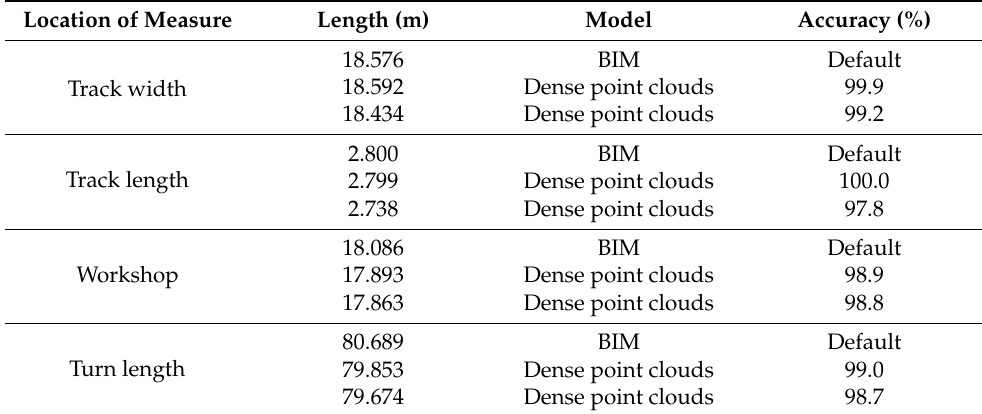
Table 2. Comparison of data accuracy between the BIM model and dense point clouds model. Location of Measure Length (m) Model Accuracy (%) Track